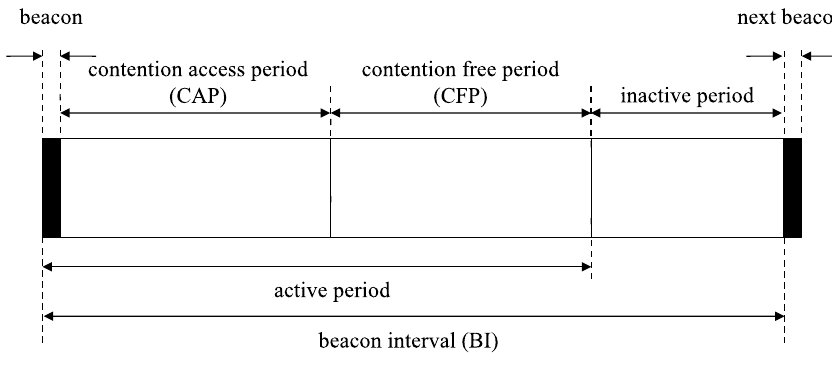
Figure 1. Superframe structure in beacon-enabled